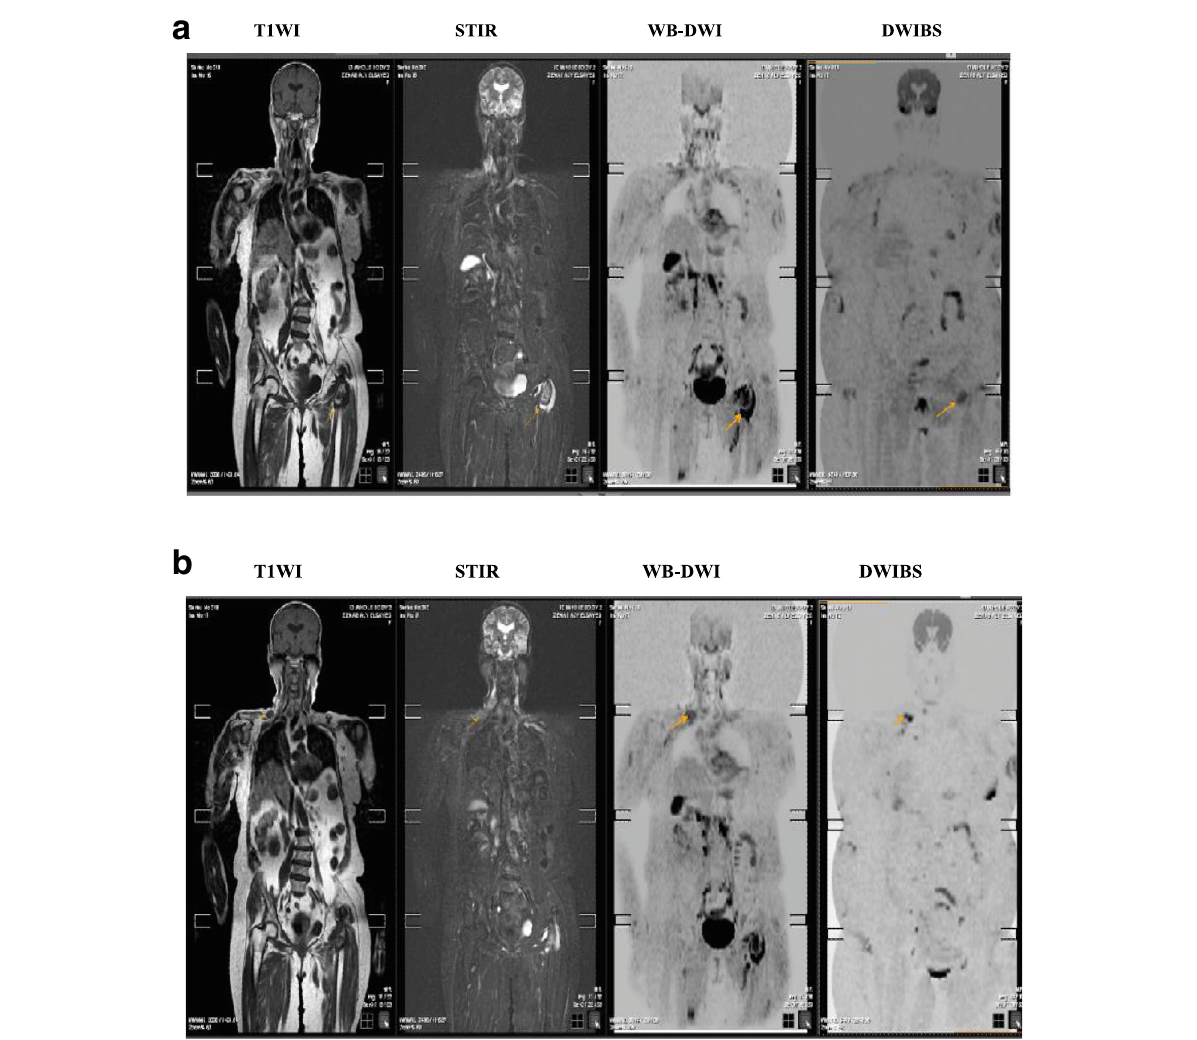
Fig. 3 A 71-year-old female with invasive duct carcinoma GII Rt. Breast. a Left hip joint lesion that appears hypo in A coronal T1WI, hyperintense in B coronal STIR (C) restricted in WB-DWI, and faintly restricted in DWIBS (D). b Right supraclavicular LN metastasis seen in A coronal T1WI, B coronal STIR, C WB-DWI, and D DWIBS. DWIBS examination could detect the LN metastasis but it could not differentiate the lesion in the left hip joint. However, WB-DWI by using ADC mapping characterize the lesion as inflammatory (osteoarthritic